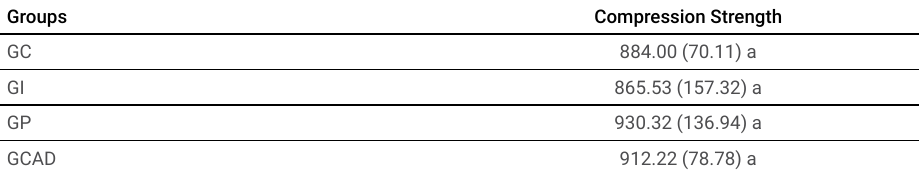
Table 2. Mean and standard deviation of compression strength (N).